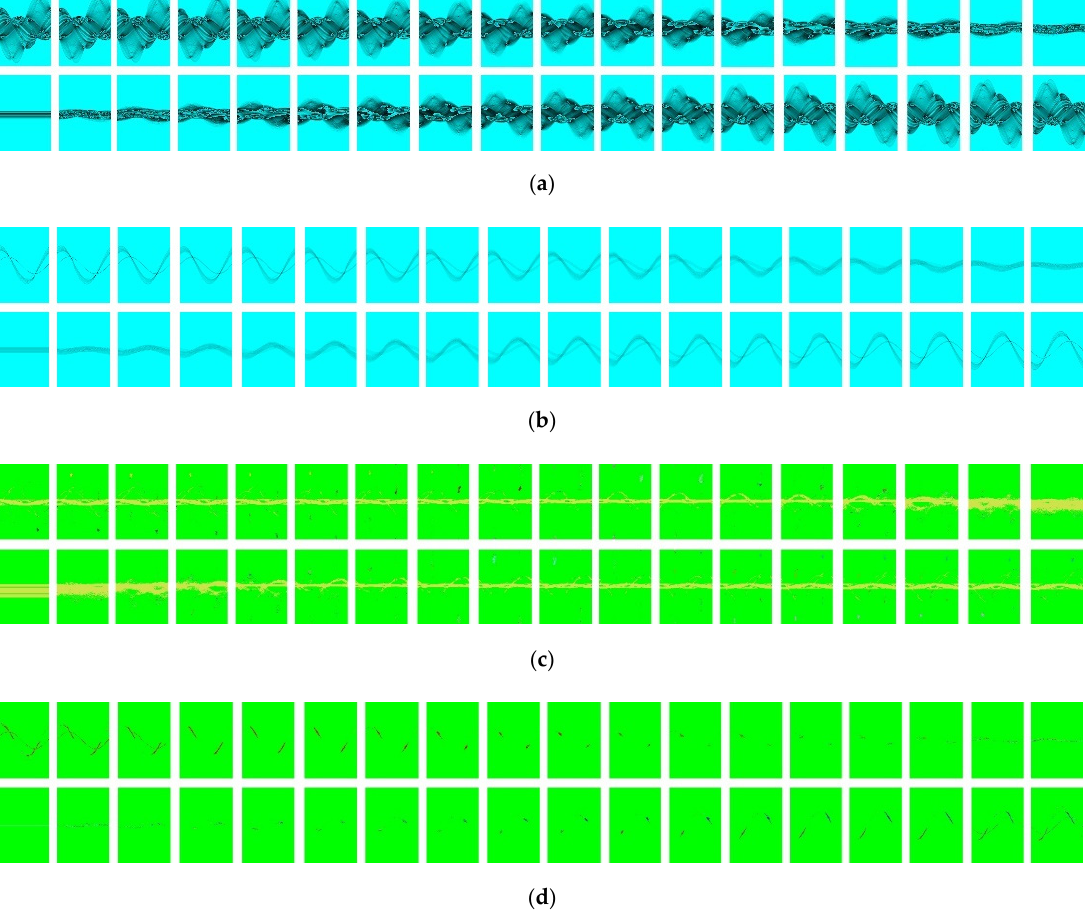
Figure 8. Hough space and flag maps generated by all point clouds and a fraction of point clouds. ( a ) The Hough space generated by all point clouds in a frame. ( b ) The Hough space generated by a fraction of the point clouds in a frame. ( c ) The flag map generated by all point clouds using a connected component labelling algorithm. ( d ) The flag map generated by a fraction point cloud using a connected component labelling algorithm.